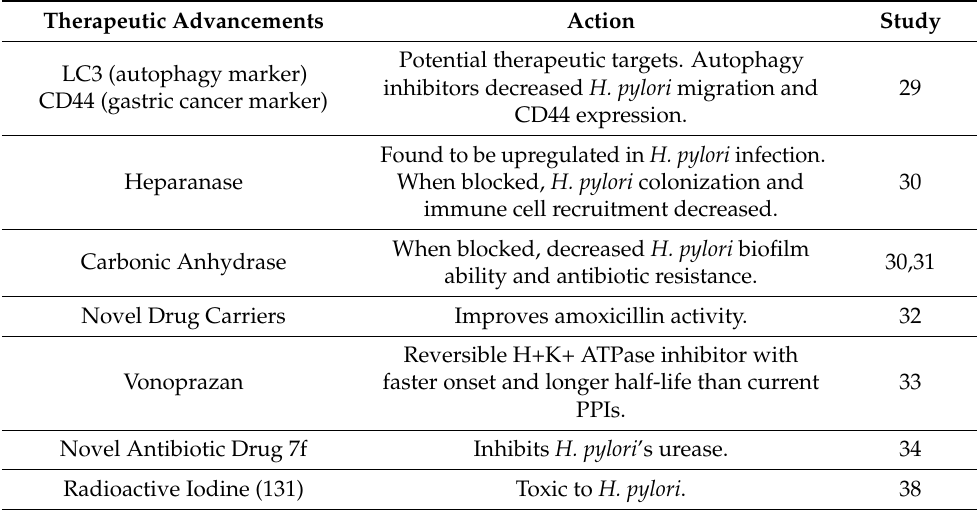
Table 2. Novel therapeutic modalities